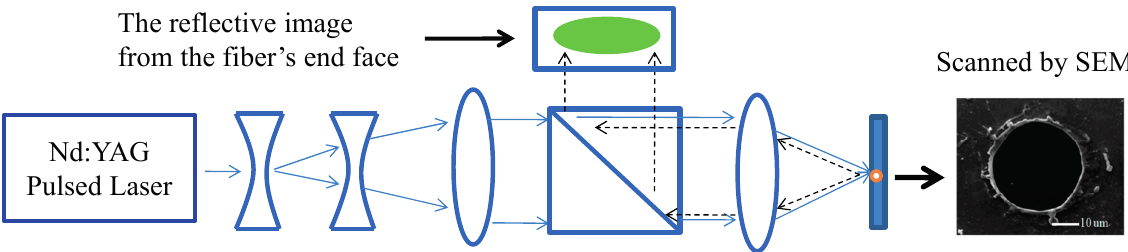
Figure 3. Nd:YAG pulsed laser drilling system was set up to drill a 30 um hole at the center of the proximal end reflector.